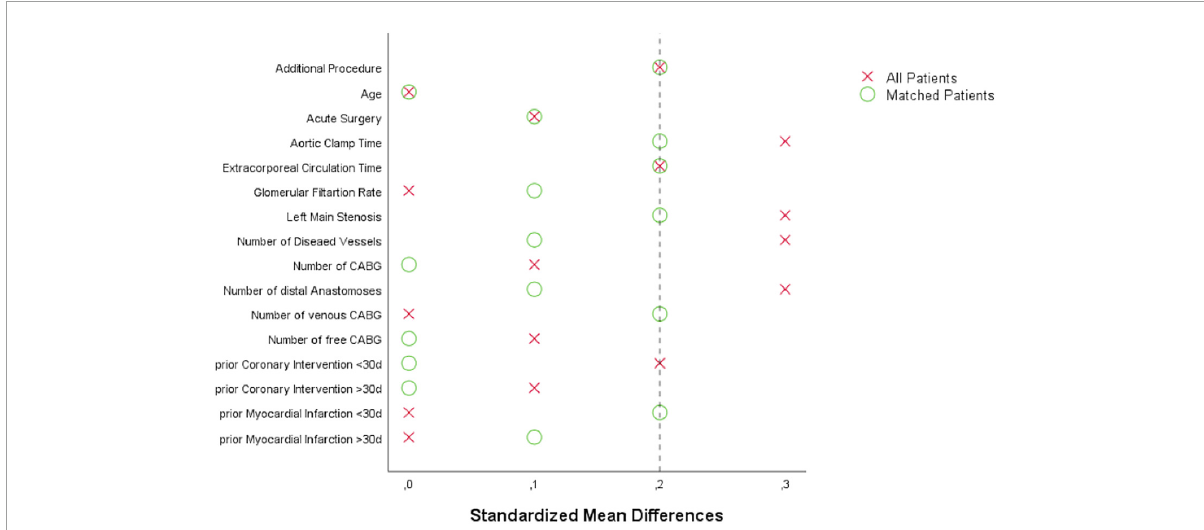
FIGURE1 Love plot visualizing covariate balancing according to standardized mean differences before and after propensity score matching: CABG, coronary artery bypass grafting.